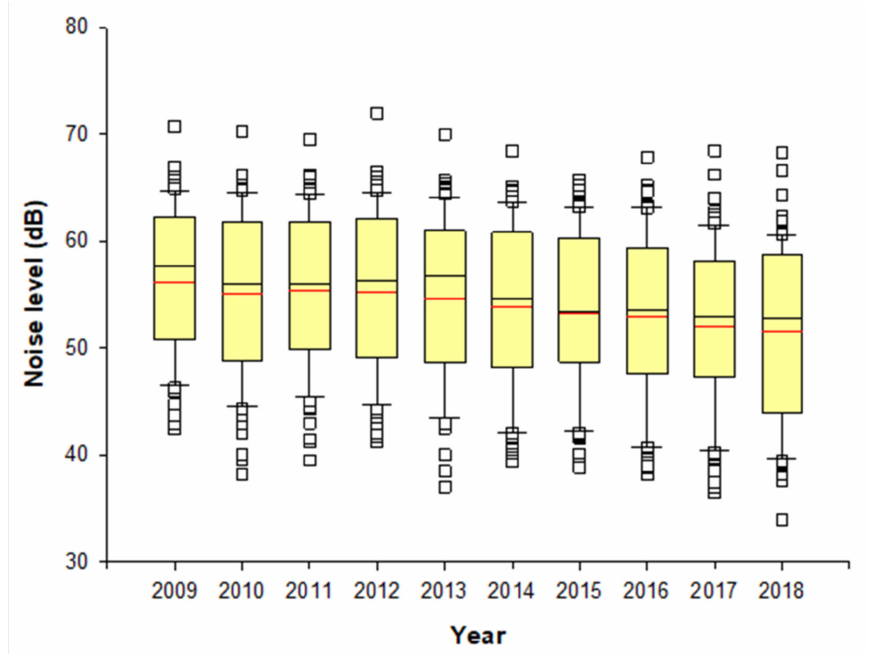
Figure 5. Distribution of annual (2009–2018) noise levels at each location of participants. Yellow box shows the interquartile range of estimated noise level, redline is the mean value, black line is the median and blank squares are the